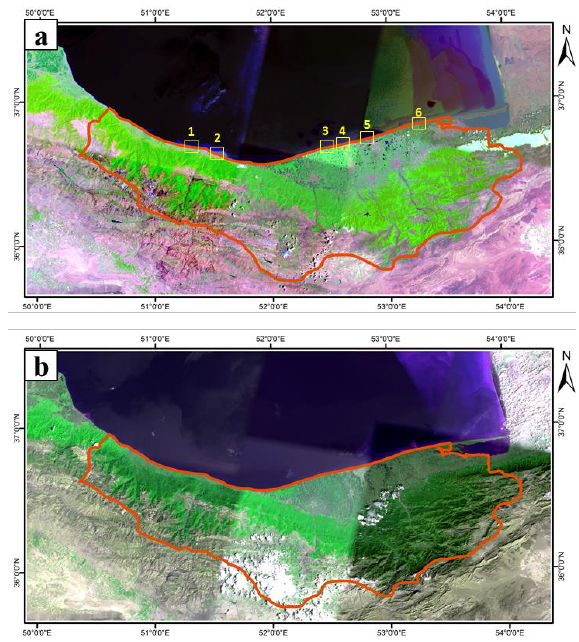
Figure 2 . Color composite images of the study area; a) OLI bands of 7, 5 and 3 as RGB; yellow boxes show the location of main shore changes; b) TM bands 2, 3 and 1 as RGB.